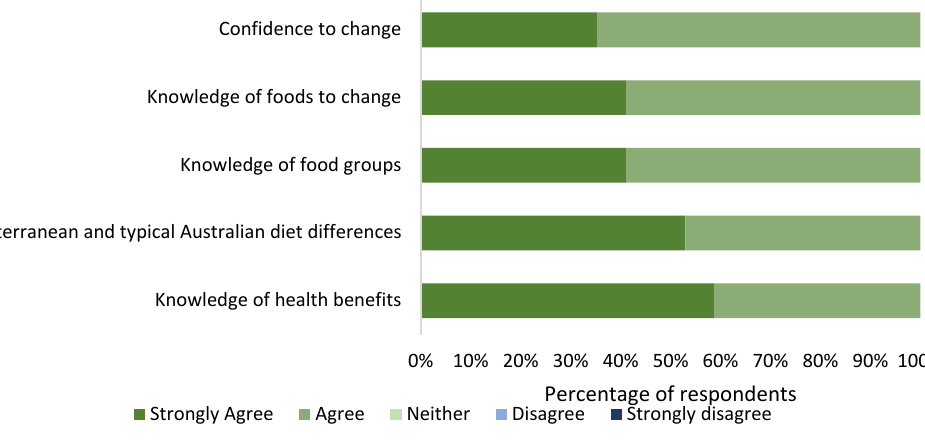
Figure 2. Consumer research group participant ( n = 17) opinions on the applicability and effectiveness of education materials and their ability to implement the AusMed diet program.